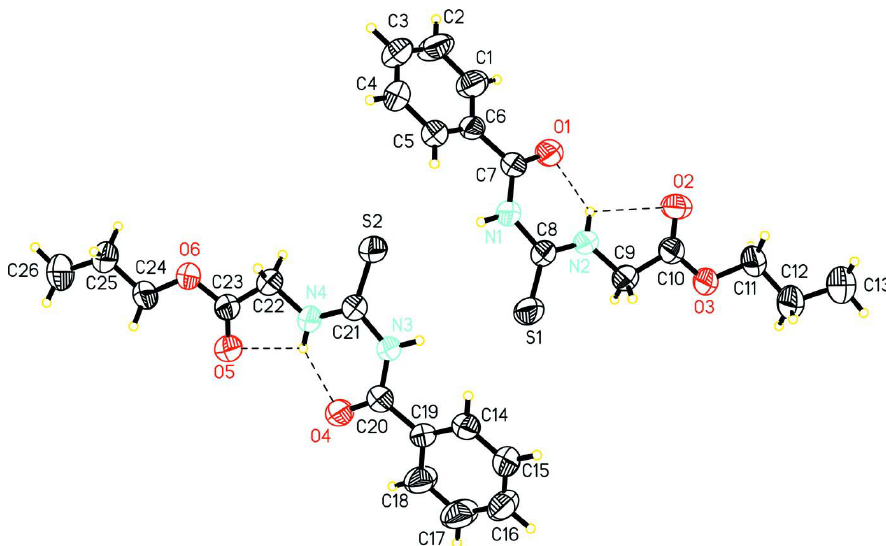
Figure 1 The molecular structure of (I), with displacement ellipsods are drawn at the 50% probability level.